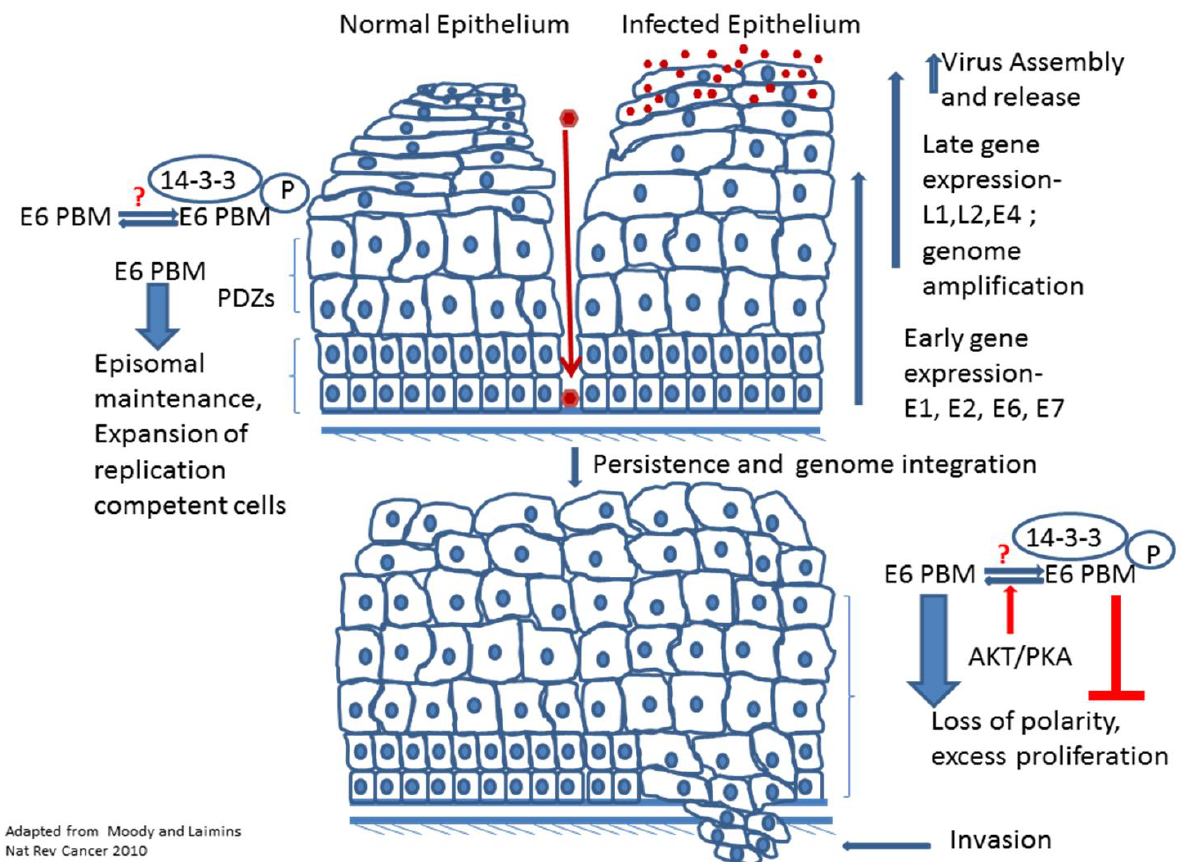
Figure 2. The role of the E6 PBM in the HPV life cycle and malignancy. The figure shows the productive life cycle of the virus after infection of the epithelium with coordinate expression of the different viral gene products during epithelial differentiation, ultimately resulting in the production of new infectious virus particles. The E6 PBM function, most likely through PDZ targeting, is required for expansion of replication competent cells and for maintenance of the viral episomal DNA. During differentiation and viral DNA amplification in the G2M like phase of the cell cycle, E6 will most likely be phosphorylated within the PBM, which could confer interaction with 14-3-3 proteins. Following a persistent infection of up to 20 years, the progression of HPV induced malignancy can occur. The role of the E6 PBM in this stage is unknown, but PDZ targeting might contribute to loss of cell polarity regulators and drive proliferation and invasion. Phosphorylation of the E6 PBM might be a means of negatively regulating this activity of